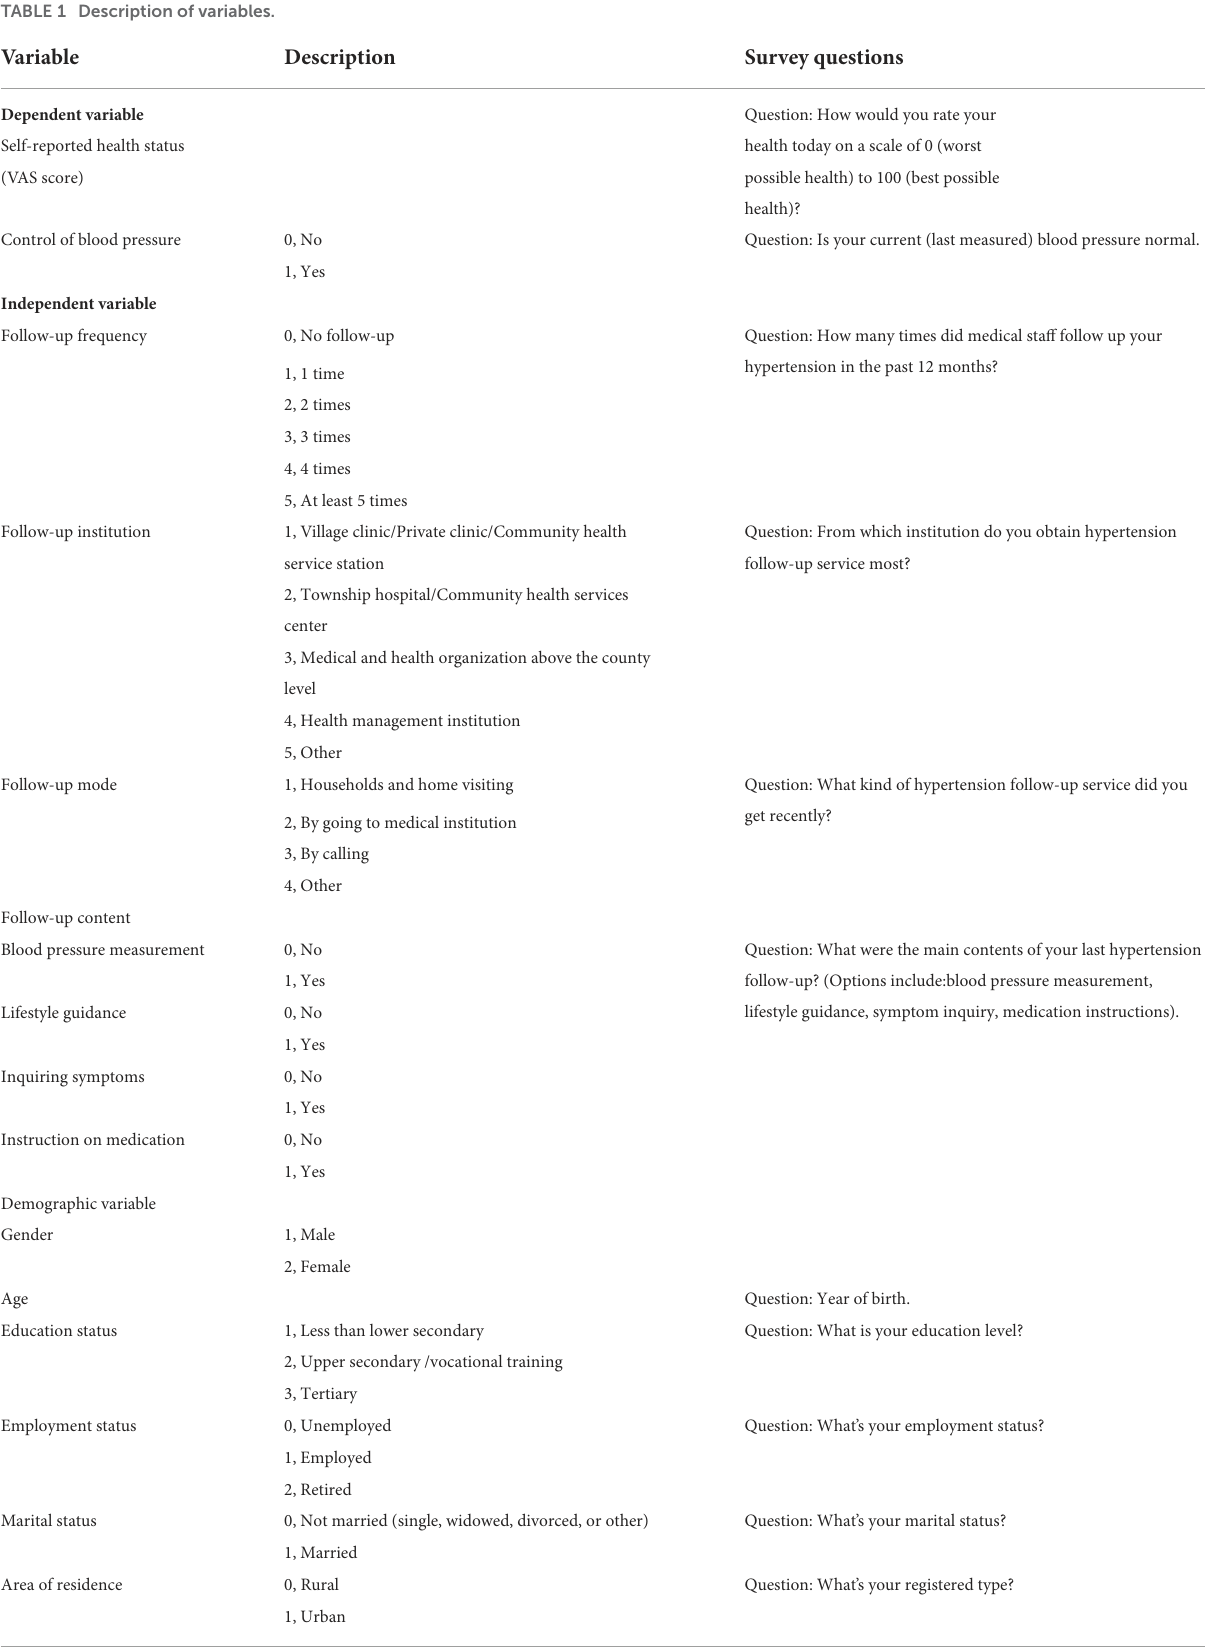
TABLE 1 Description of